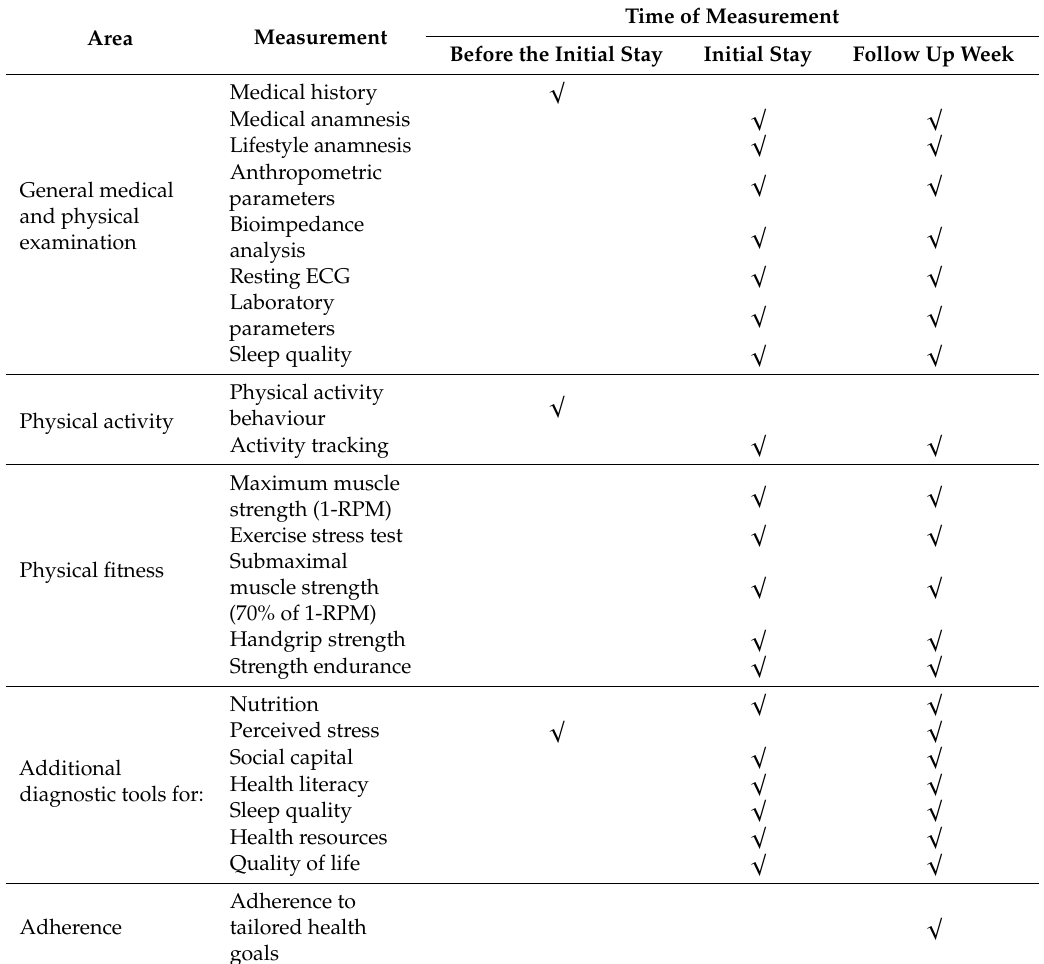
Table 2. Overview of the set of diagnostic